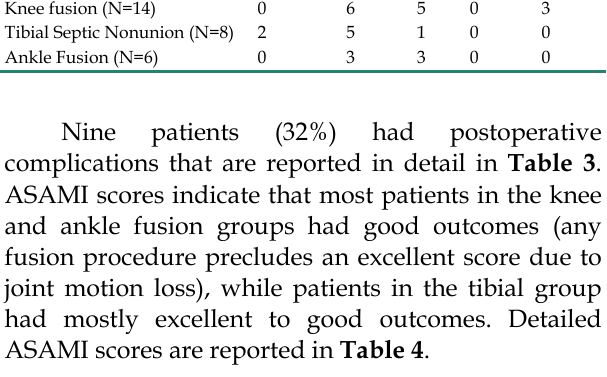
Table 4. ASAMI Function Score by Treatment Group Treatment group Functional ASAMI Score Excellent Good Fair